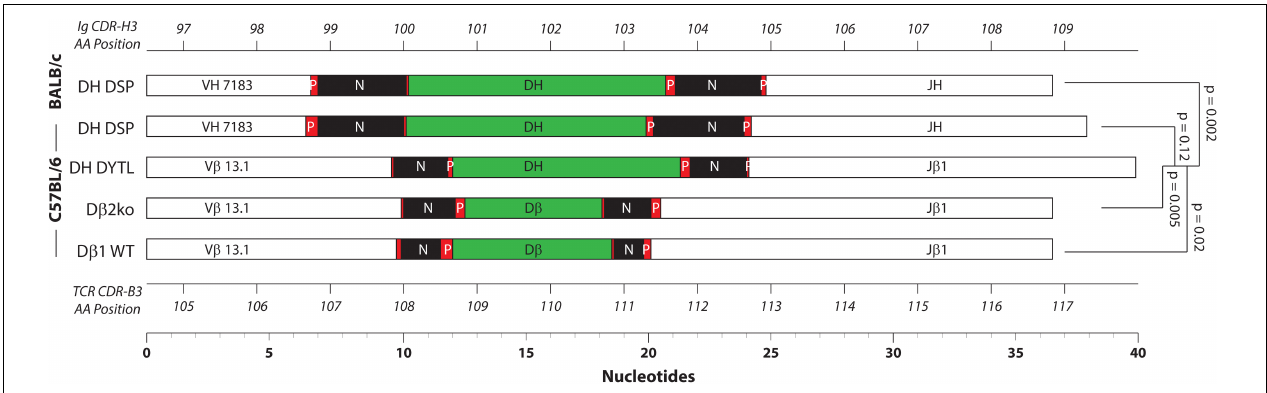
FIGURE 5 | Relative distribution of the CDR3 components. Shown together are the average length of V, D, and J gene segments, P junctions, and N addition in nucleotides for each of the mouse strains. From top to bottom: Fraction B BABL/c and pro B C57BL/6 CDR-H3 sequences, followed by CDR-B3 sequences from D β YTL, D β 2ko, and D β 1 wild type thymocytes. Statistical analysis was performed only for D β YTL in comparison with the four controls. Shown at the top is the codon position number for CDR-H3, and at the bottom the codon position number for